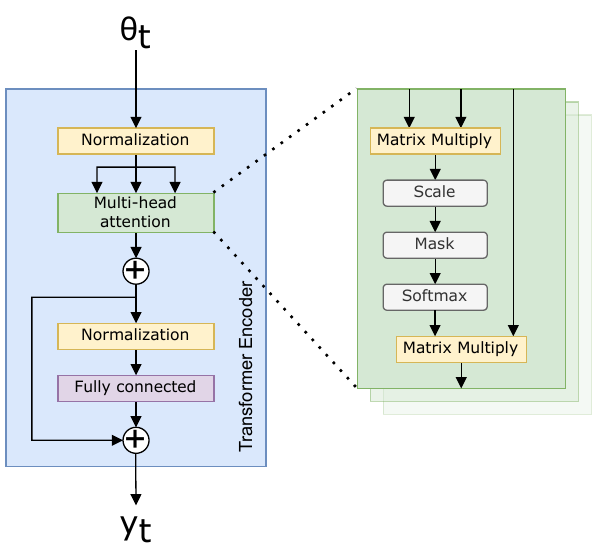
Figure 2. Transformer neural network